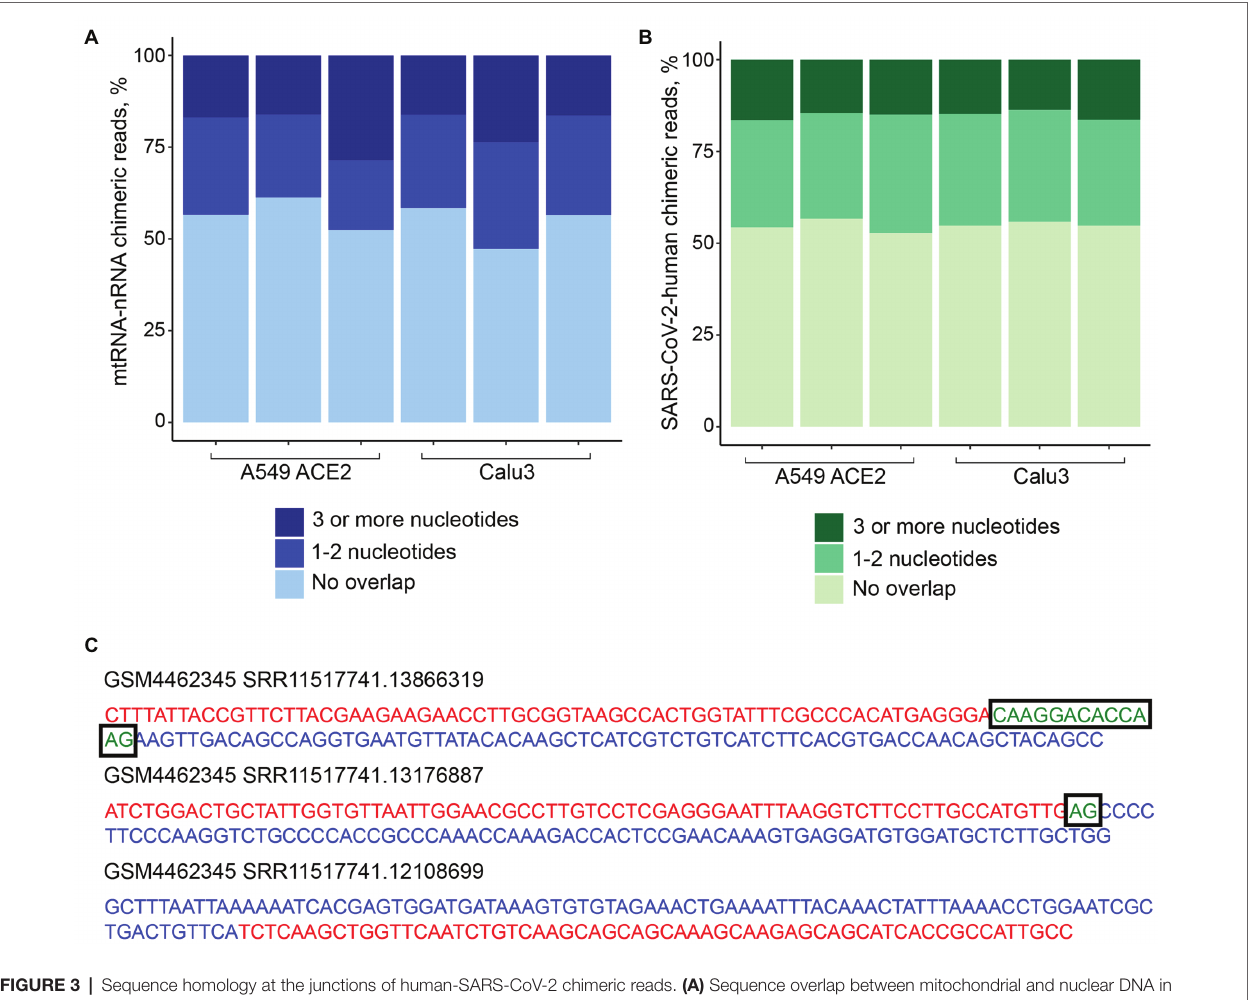
FIGURE 3 | Sequence homology at the junctions of human-SARS-CoV-2 chimeric reads. (A) Sequence overlap between mitochondrial and nuclear DNA in mitochondrial RNA-nuclear RNA (mtRNA-nRNA) chimeric reads. Each bar presents each of the triplicates of SARS-CoV-2 infected A549 ACE2 and Calu3 cells. (B) Sequence overlap between SARS-CoV-2 genomic RNA and the human genome in human-SARS-CoV-2 chimeric reads in the same samples. (C) Representative examples of human-SARS-CoV-2 chimeric reads with 13, 2, and 0 nucleotide overlap. SARS-CoV-2 and human genomic sequences are shown in red and blue letters, respectively. Overlapping sequences are shown in boxed green